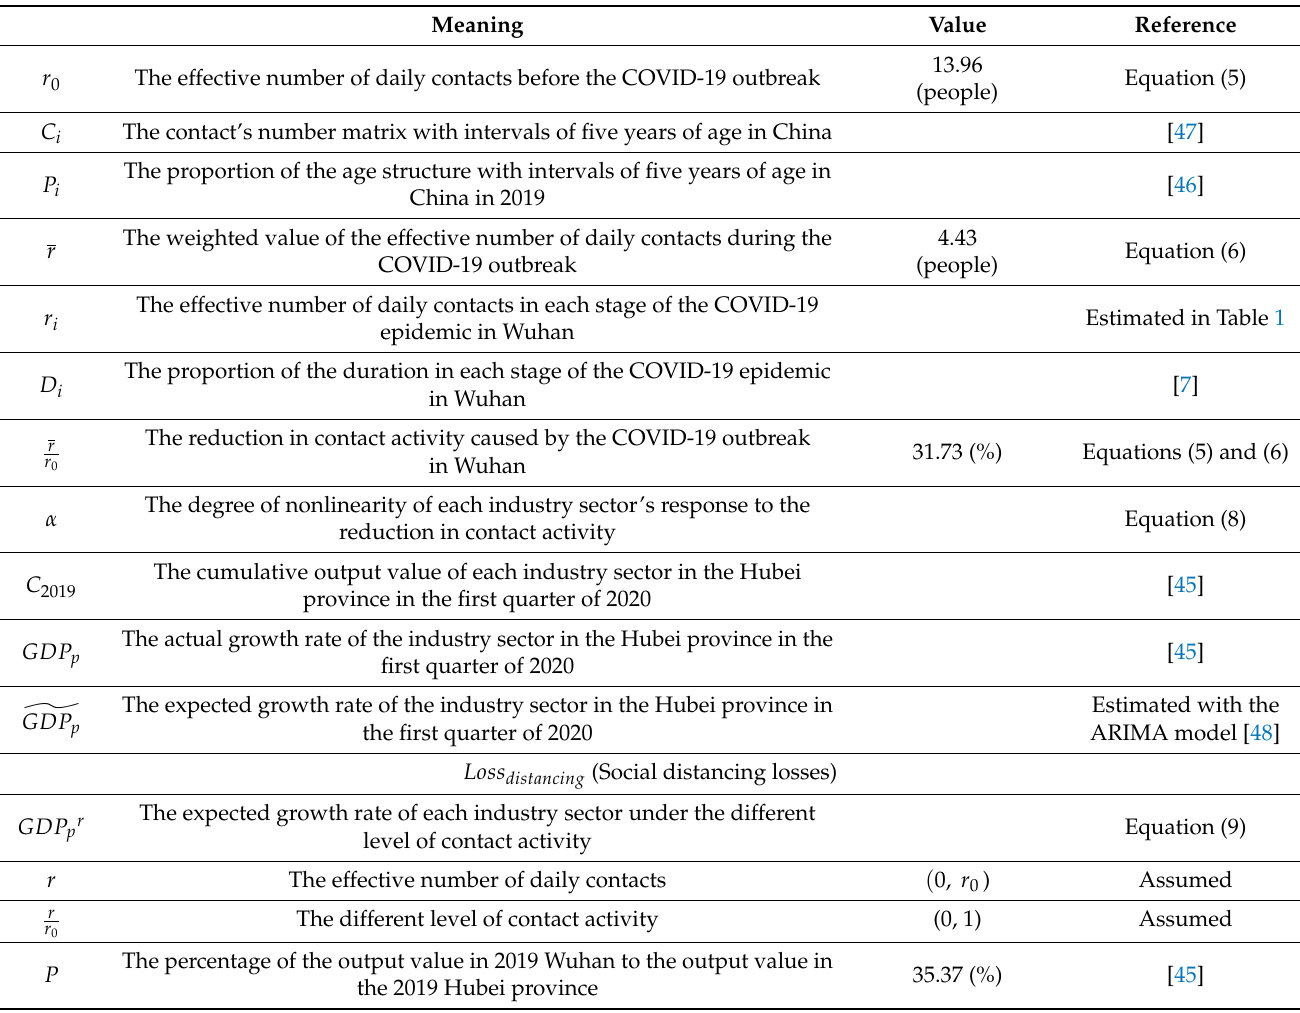
Table 3. Parameters of estimating social distancing